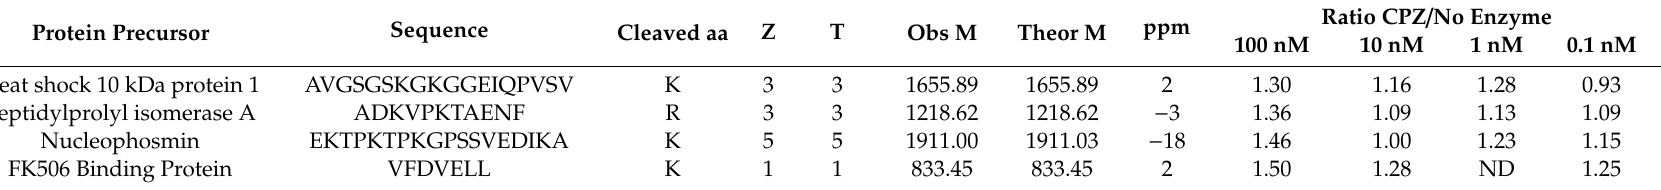
Table 3. Products of CPZ identified using the HEK293T peptide